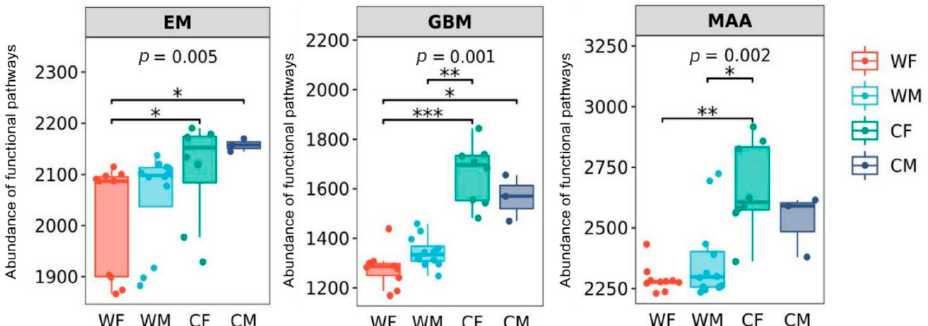
Figure 5. Microbial functions related to energy metabolism (EM), glycan biosynthesis and metabo- lism (GBM), and metabolism of other amino acids (MAA) grouped by sex and environment (WF: wild female; WM: wild male; CF: captivity female; CM: captivity male). * represents significant ( p < 0.05), ** represents very significant ( p < 0.01), and *** represents highly significant ( p < 0.001) (WF: n = 10, WM: n = 12, CF: n = 8, CM: n = 3).